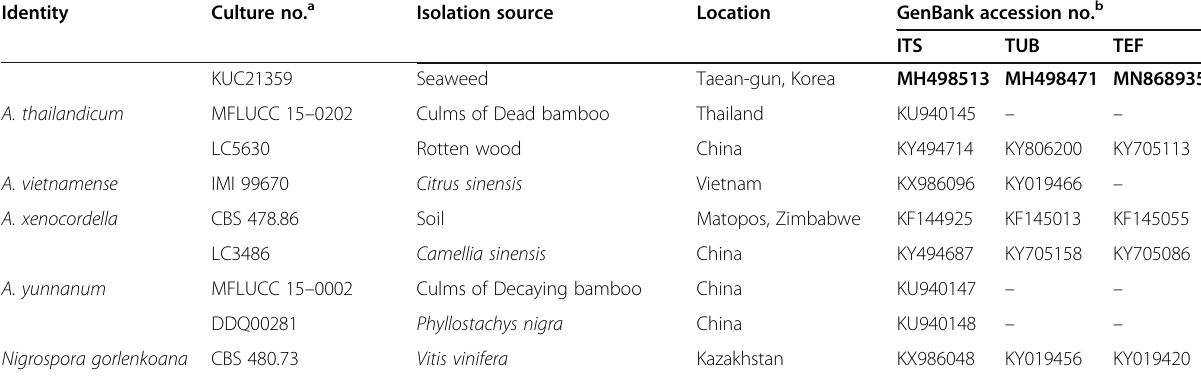
Table 1 A list of all the strains included in the phylogenetic analysis